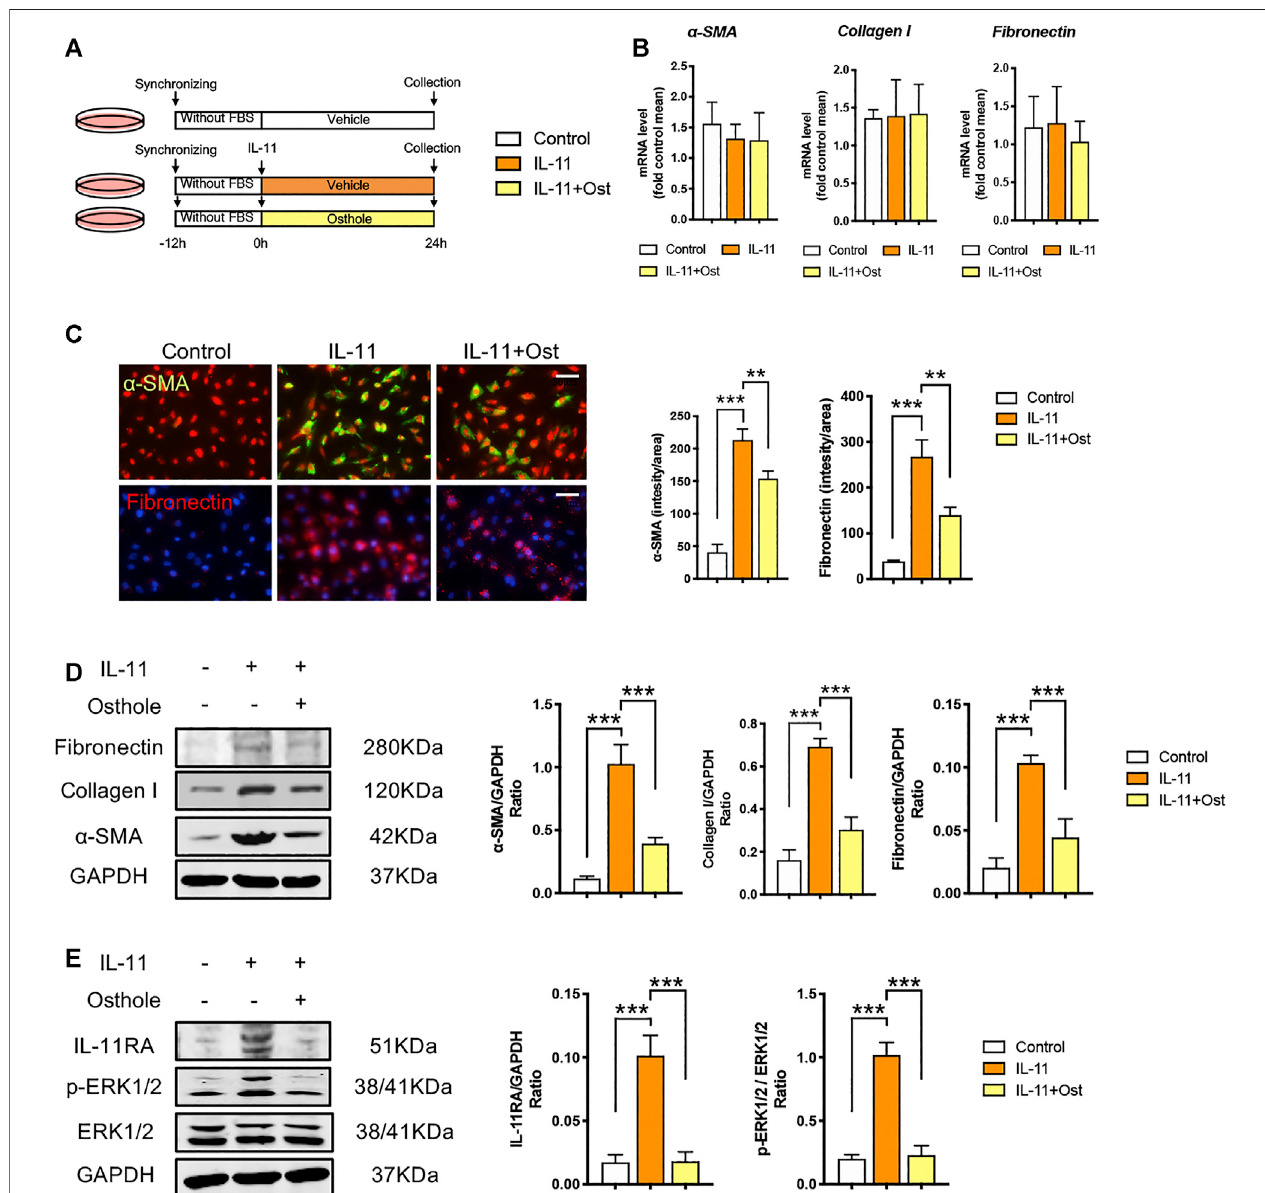
FIGURE4| The anti fi brogenic effects ofostholecanbe mediatedbyIL-11/ERK1/2 signaling pathway. (A) invitro experimentalprotocol ofthispart. (B) ThemRNA levels of α -SMA, collagen I and fi bronectin in HK-2 cells of different groups. ( n (cid:1) 4 repeats) (C) Representative immuno fl uorescence staining for α -SMA and fi bronectin; the quanti fi cation of α -SMA and fi bronectin immuno fl uorescence staining. Scale bar, 50 μ m. ( n (cid:1) 4 repeats) (D) Representative western blots for α -SMA, collagen I and fi bronectin protein expressions in HK-2 cells; the quanti fi cation of α -SMA, collagen I and fi bronectin western blots. ( n (cid:1) 4 repeats) (E) Representative western blots for IL-11RA, p -ERK1/2 and ERK1/2 protein expressions in HK-2 cells; the quanti fi cation of IL-11RA, p -ERK1/2, and ERK1/2 western blots. ( n (cid:1) 4 repeats). All data are presented as means ± SD. * p < 0.05, ** p < 0.01, *** p < 0.001.